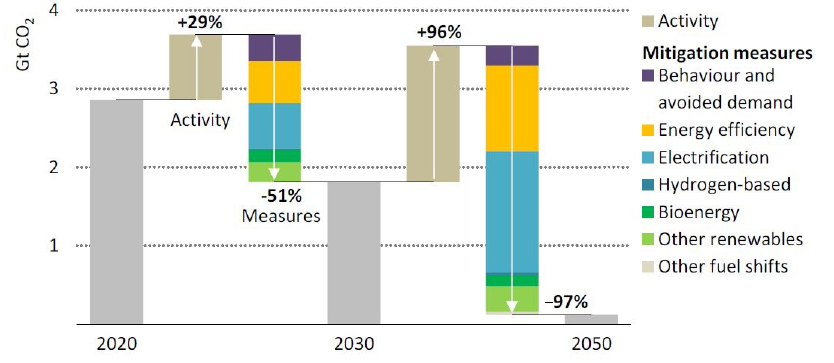
Figure 2. Global direct CO 2 emission reductions by mitigation measure in buildings in the NZE